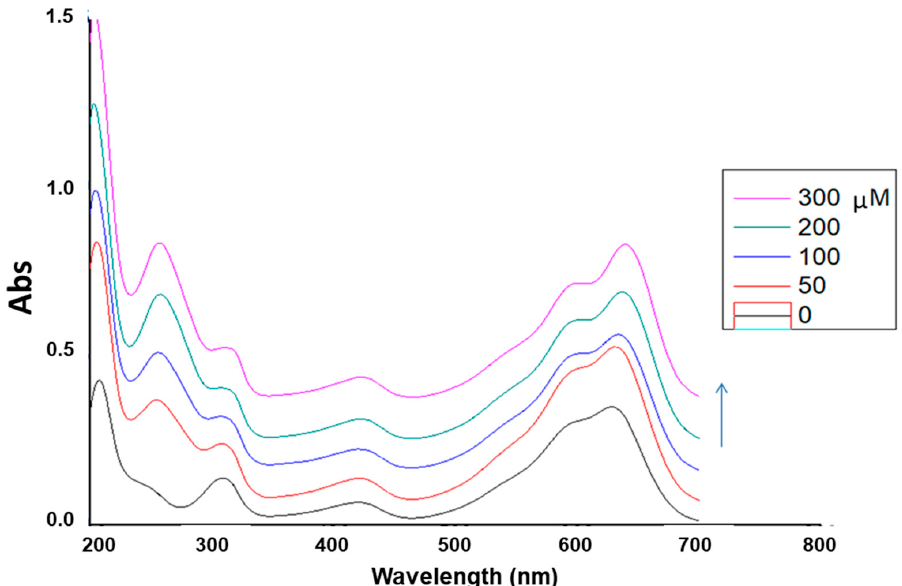
Figure 9. Absorption spectra of methyl green in Tris-HCl buffer with increasing concentration of